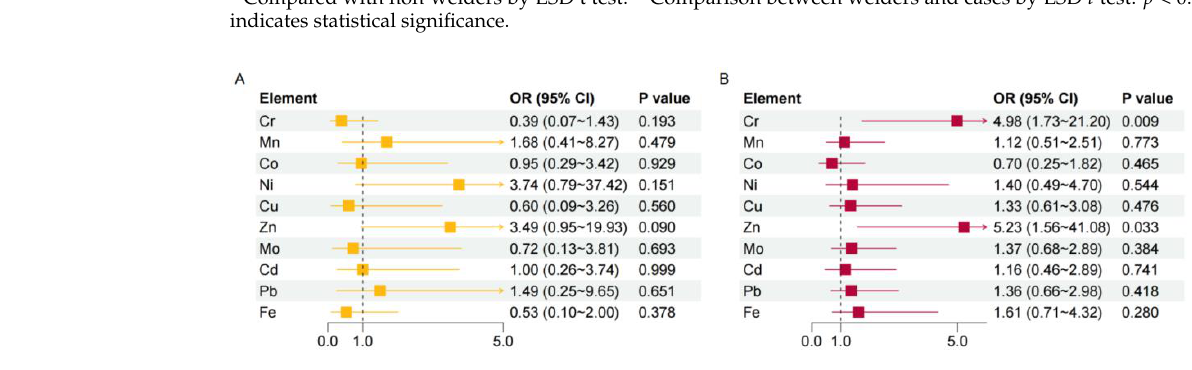
Figure 1. Analysis of the risk of pneumoconiosis for different metals. The associations between urinary ( A ) or haemal ( B ) metals with welder’s pneumoconiosis risk were estimated by logistic regression models with adjustment for age, BMI, working years, welding dust exposure years, and smoking status. p < 0.05 indicates statistical significance. OR, odds ratio; CI, confidence interval. Table 3. The association between metal levels and lung function in cases with welder’s pneum oco- niosis.